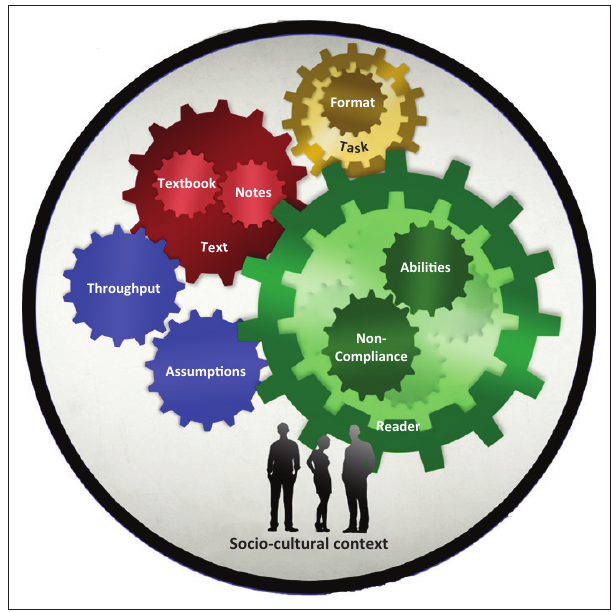
FIGURE 1: The reading mechanism: Barriers to reading within the reader, the text, the task and the socio-cultural